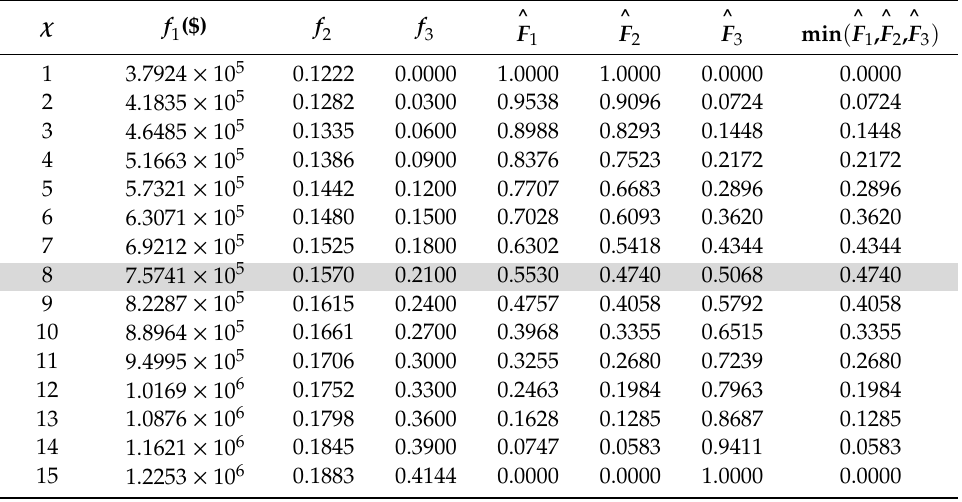
Table 13. Obtained Pareto optimal solutions for the probabilistic multi-objective RPP considering the wind generation